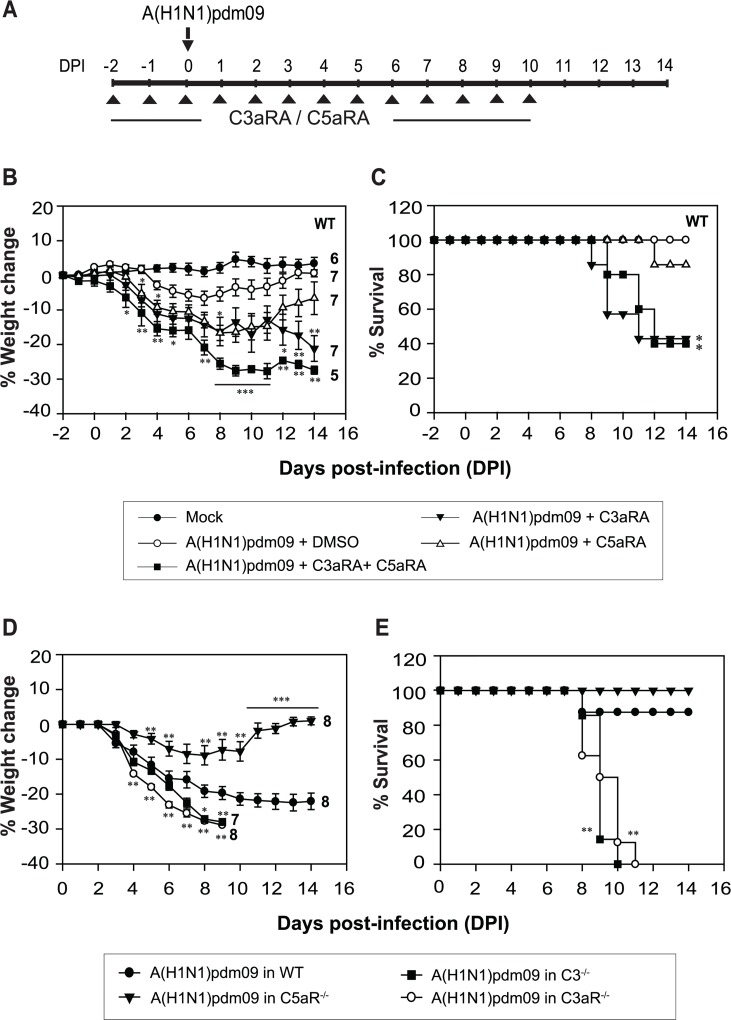
C3a signaling is primarily important for generating protective immune response against the A(H1N1)pdm09 virus.A) Schematic diagram showing the experimental setup. WT (C57BL/6) mice administered with C3aRA or C5aRA or both (1mg/kg of body weight through i.p. route) were infected intranasally with 450 TCID50 of the virus in PBS and monitored for weight loss and survival for 14 days post-infection. Arrow indicates the day of infection and arrowheads indicate the days on which C3aRA and/or C5aRA was injected. B) Percentage of body weight loss during infection in indicated mice groups; numbers at the end of the lines indicate the number of animals. Significant weight loss was observed in all the receptor antagonist treated groups compared to untreated group (*p <0.05, **p < 0.002 and ***p < 0.0001). C) Percentage of survival during the infection in indicated mice groups. The survival in C3aRA and C3aRA/C5aRA treated mice was significantly lower than in WT mice (*p <0.02). Results represent mean ± SEM of two independent experiments. D) Percentage of body weight loss during the infection in C3aR-/-, C5aR-/- and C3-/- mice (all on BALB/c background) in comparison to WT (BALB/c) mice. Results represent mean ± SEM. (*p <0.05, **p < 0.02 and ***p < 0.001). E) Percentage of survival during the infection in C3aR-/-, C5aR-/- and C3-/- mice on BALB/c background in comparison to WT (BALB/c) mice. The C3aR-/- and C3-/- mice showed complete mortality, while WT and C5aR-/- mice showed little or no mortality (**p ≤ 0.002).